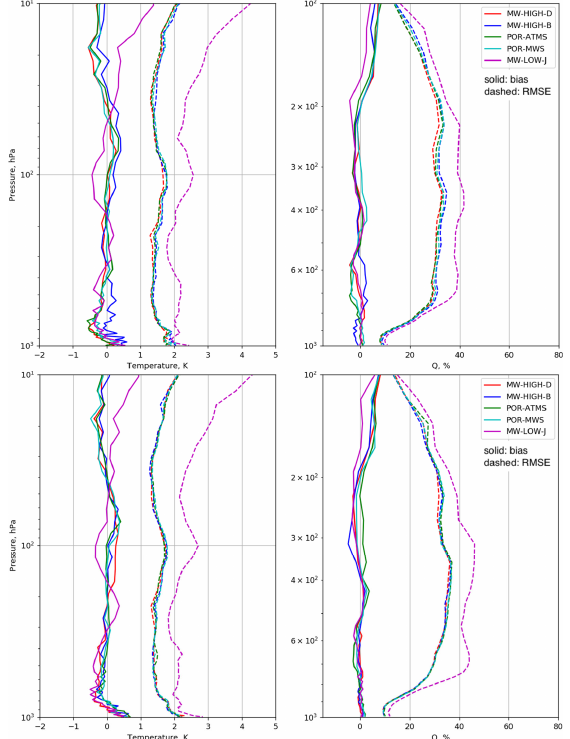
Figure 4. Assessment of MIIDAPS ‐ AI applied to simulated (using G5NR) observations for several MW instrument configurations. The top panel shows performance in clear ‐ sky conditions, while the bottom panel shows performance in all ‐ sky conditions (clear, cloudy and precipitating). Solid and dashed lines respectively correspond to the mean bias and the root ‐ mean ‐ squared (RMSE) between MIIDAPS ‐ AI and G5NR. Cloud and precipitation retrieval information content were also assessed for the four model atmospheres. Normalized values are shown in Figures 2 and 3, however most sen ‐ sor configurations are sensitive to 0.5–1 𝑑𝑓𝑠 (integrated column) for cloud liquid water. Precipitating graupel/snow and rain 𝑑𝑓𝑠 are between 1 and 2 𝑑𝑓𝑠 indicating some sen ‐ sors have some profile ‐ sensing capability albeit limited to a vertical shift in the profile. As expected, graupel sensitivity is somewhat enhanced over higher emissivity (land ‐ like) while rain sensitivity is somewhat enhanced over lower emissivity surfaces (ocean ‐ like).